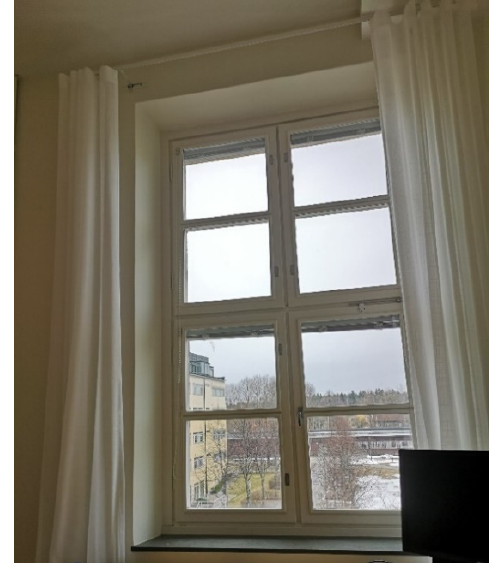
Figure 3. Room B(s) window. Table 2. Curtain information and dimension. Table 2. Curtain information and